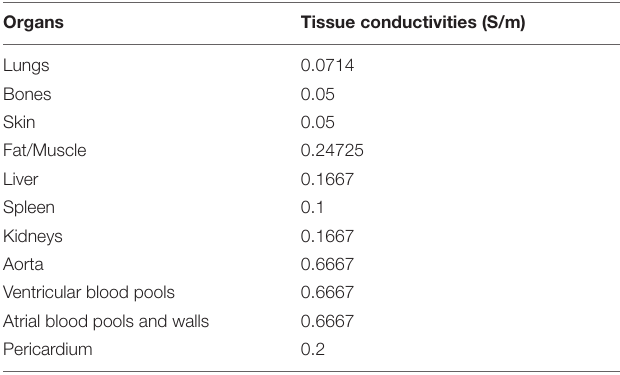
TABLE 1 | Organ conductivities of our torso